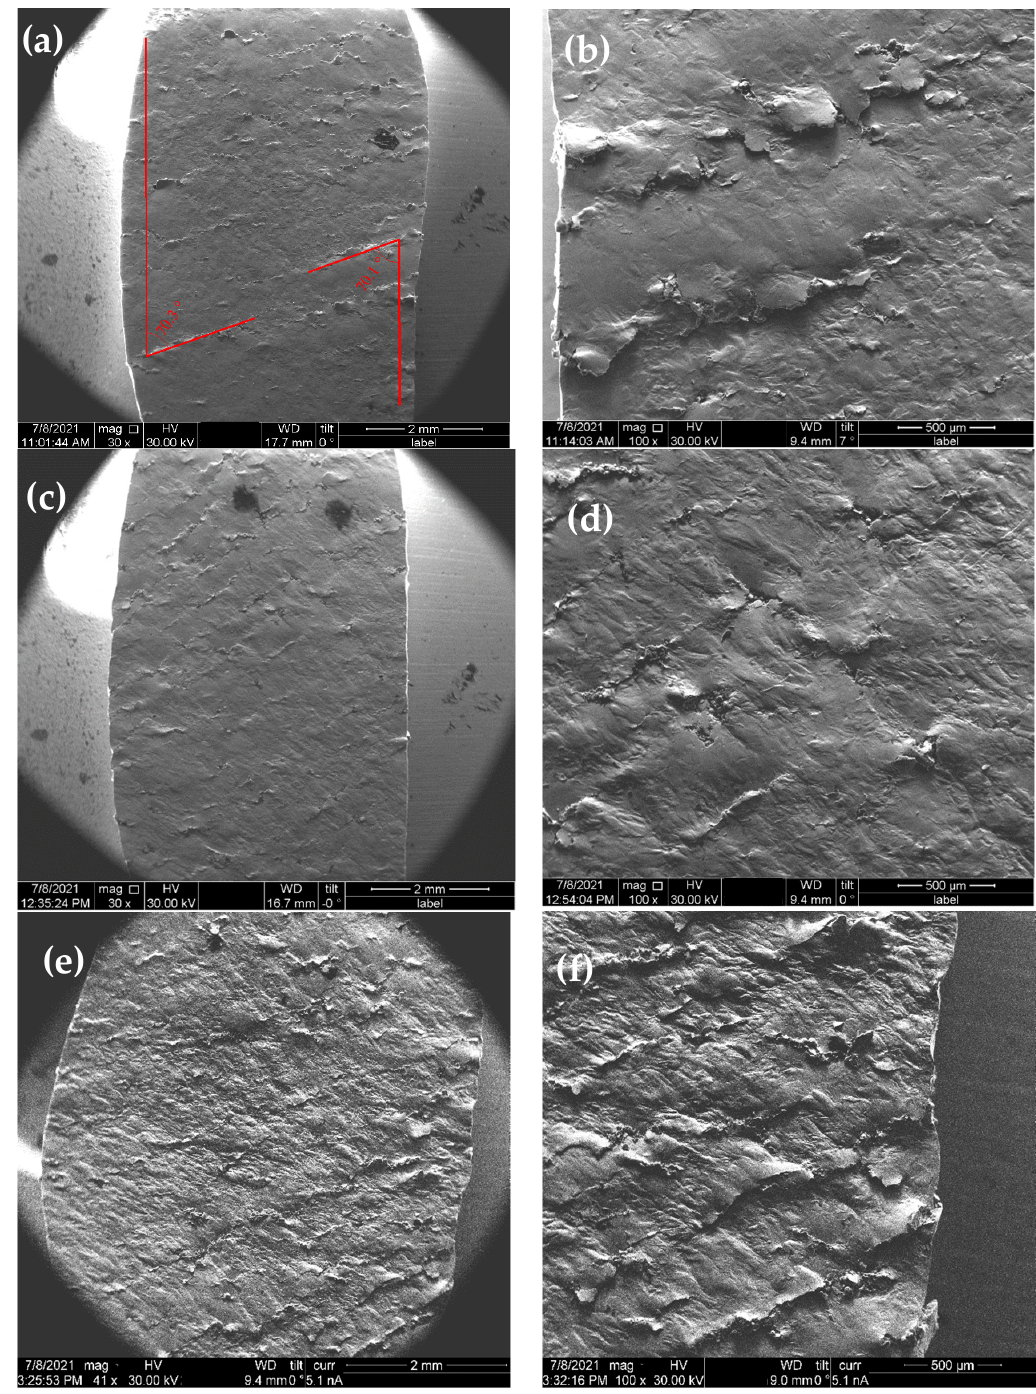
Figure 4. Strain localization bands in the studied samples after deformation, the different magnifi- cation, and scanning electron microscopy (SEM): ( a , b ) strain rate 2 × 10 − 2 s − 1 ; ( c , d ) strain rate 3 × 10 − 3 s − 1 ; ( e , f ) strain rate 8 × 10 − 4 s − 1 . The cellular-dendritic structure was observed in the initial as-built sample; the grain sizes were determined to be from 10 to 40 microns (Figure 5a). In the deformed samples inside the grains, one can see the formation of elongated grains with an internal banded structure, which was associated with the process of twinning (Figure 5b–d).